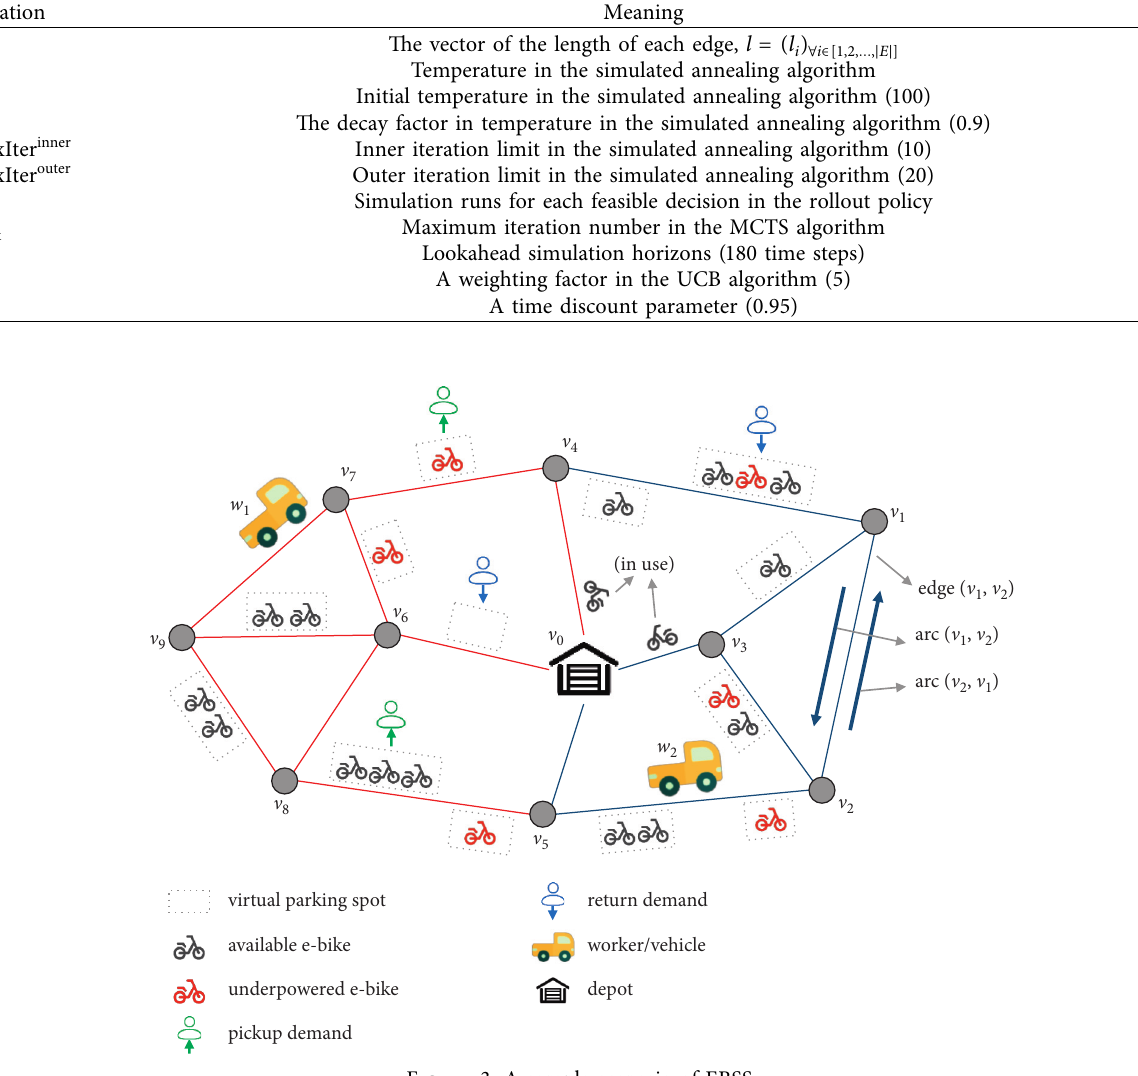
Figure 3: A sample scenario of